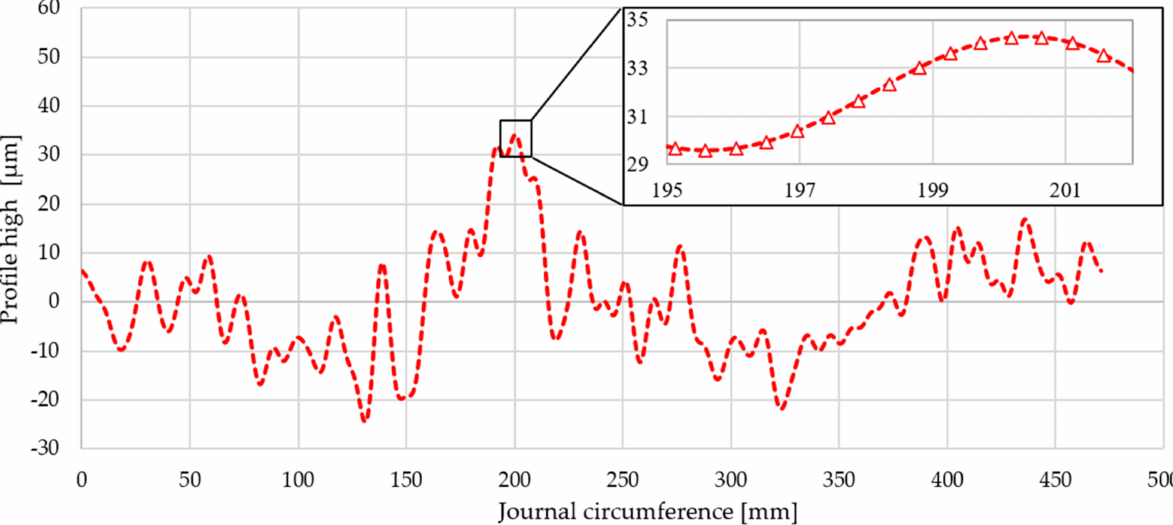
Figure 15. Actual measured outline of the roundness of journal No. 10 developed over a length equal to 471 mm, which corresponds to the circumference of a wheel with a nominal diameter of the measured main shaft journal of 150 mm.